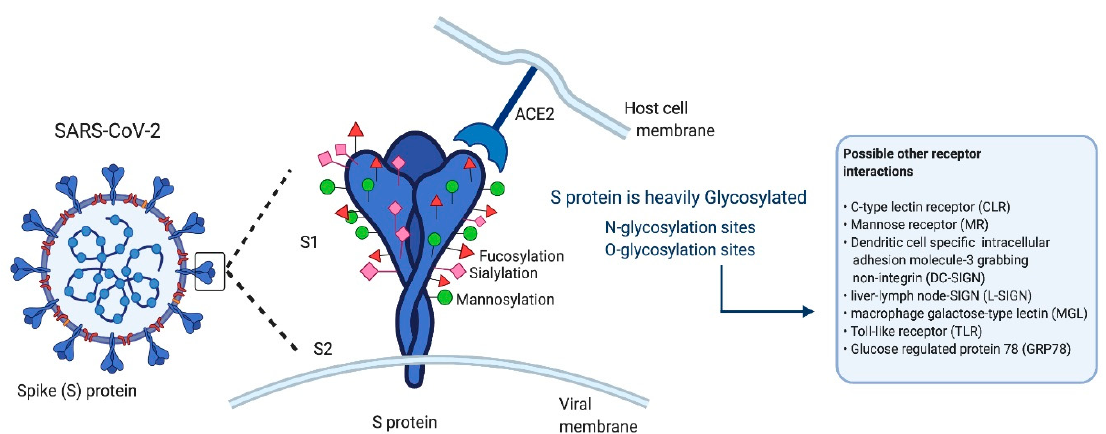
Figure 1. Schematic representation of SARS-CoV-2 virus showing the Spike (S) protein which is heavily glycosylated (O-glycosylation and N-glycosylation) with numerous fucose, mannose and sialyl residues. These sugar moieties have the potential to bind to C-lectin type receptors (CLR), mannose receptor (MR), dendritic cell-specific intracellular adhesion molecule-3-grabbing non-integrin (DC-SIGN), homologue dendritic cell-specific intercellular adhesion molecule-3-grabbing nonintegrin related (L-SIGN), macrophage galactose-type lectin (MGL), toll-like receptors (TLR), and glucose regulated protein 78 (GRP78).